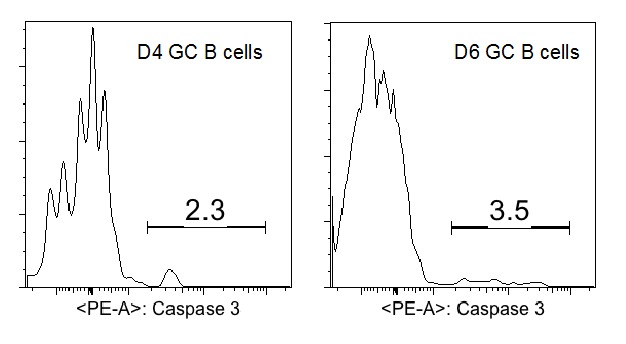
DOI:
http://dx.doi.org/10.7554/eLife.19552.020